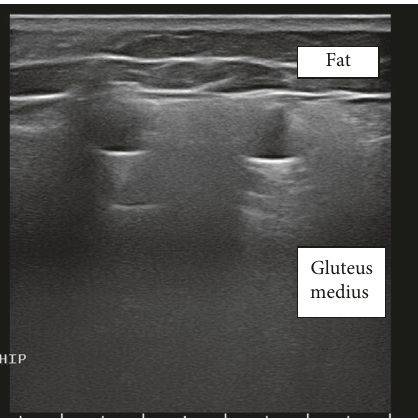
Figure 1: Ultrasound of the left hip showing dense hypo- echogenicty of the gluteus medius with loss of normal echotexture and hyperechoic appearance as well as several anechoic areas posteriorly.